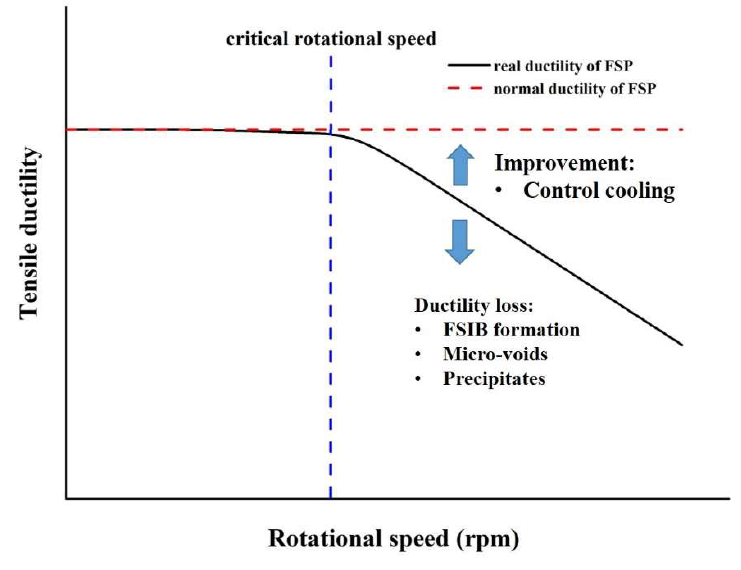
Figure 13. A schematic diagram of tensile ductility improvement during hyper-rotational applications of FSP.